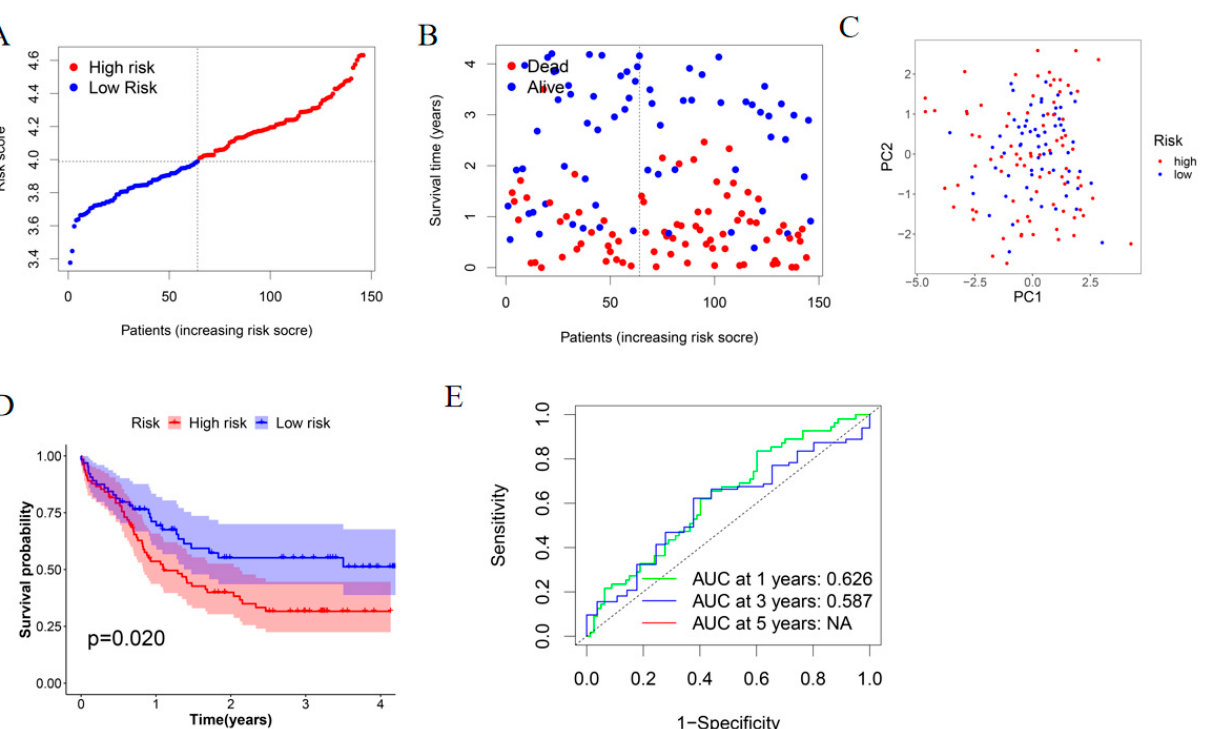
Figure 4. Verification of the prognostic risk model in the GEO cohort. ( A ) Distribution of AML patients in the GEO cohort based on their risk score. ( B ) The survival status distribution of each patient in the GEO cohort. ( C ) PCA plot for AML patients in the GEO cohort. ( D ) Kaplan-Meier curve of high-risk and low-risk groups. ( E ) Time-dependent ROC curves for AML patients in the GEO cohort.